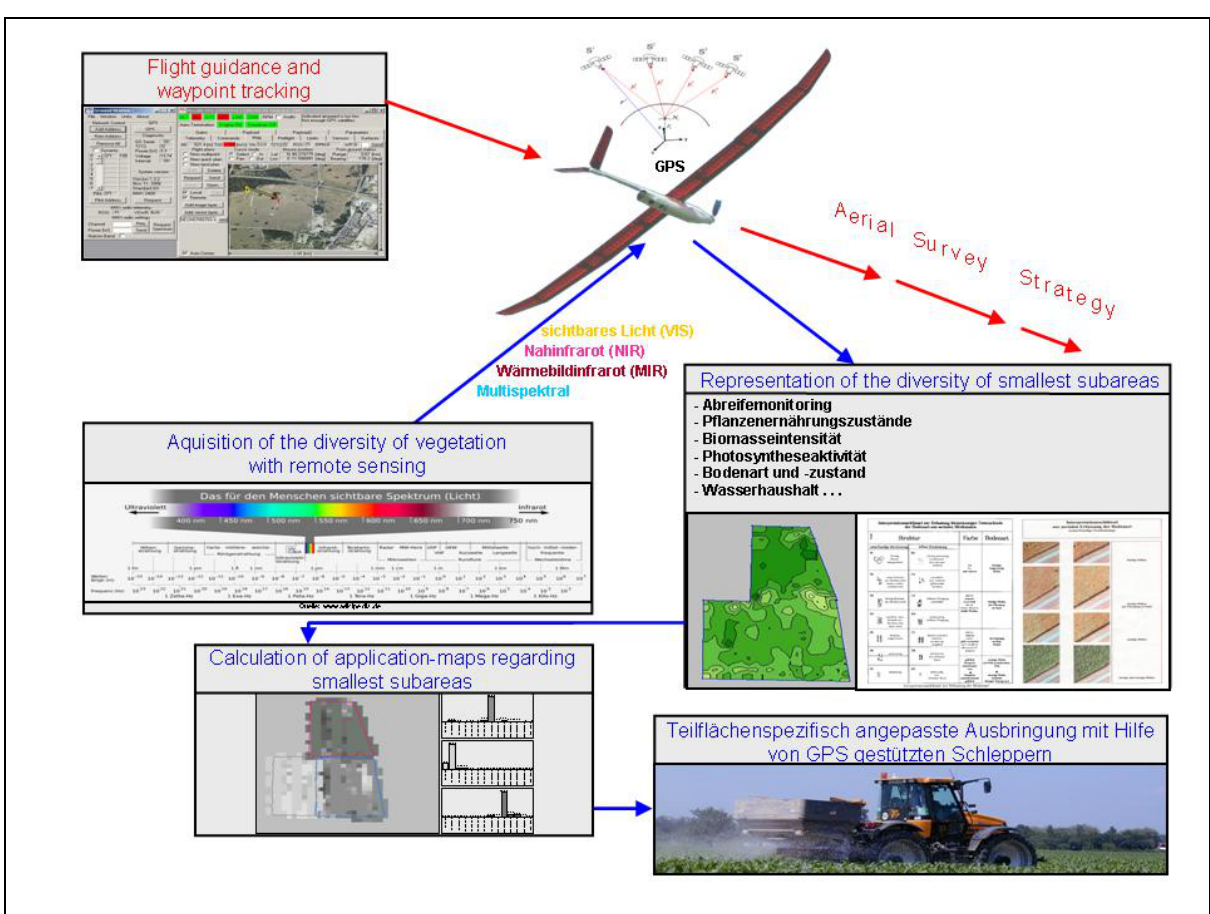
Figure 1 : UAV with exchangeable payload module for data acquisition in precision farming, forestry and geoinformation